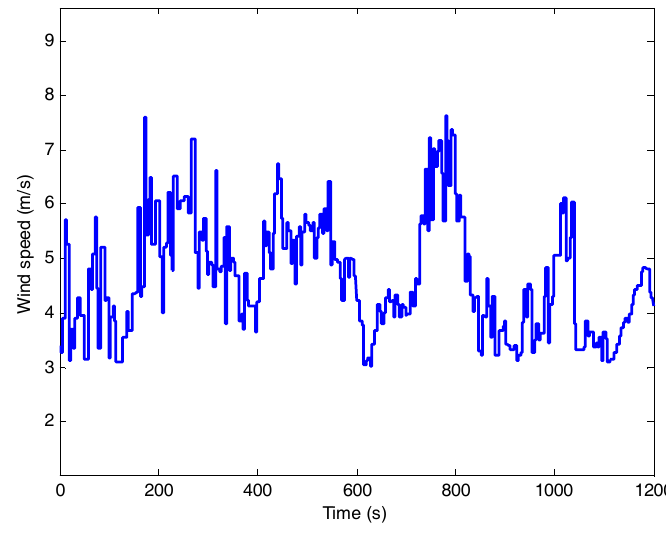
Figure 5. Wind speed.